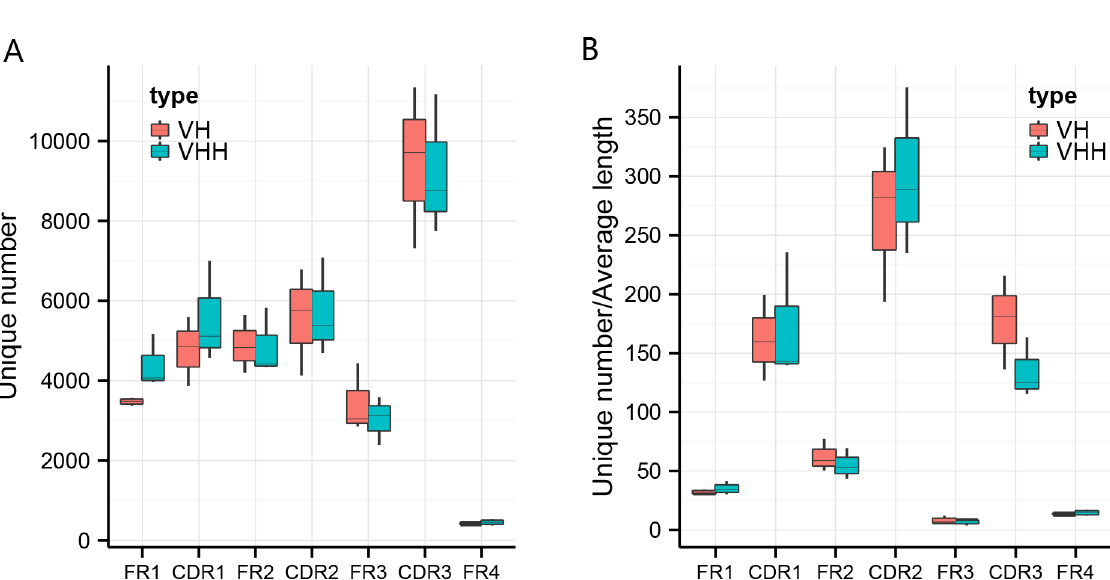
Fig 2. Box plots of the unique sequence numbers of each sub-region and diversity evaluation. Unique number represents the number of unique sequences within the reads. a The unique number of sub-regions including FR1, CDR1, FR2, CDR2, FR3, CDR3, and FR4 in three samples. b Diversity evaluation using the normalized unique number by length, which equals to unique number divided by average length of each sub-region. Box plot explanation: upper horizontal line of box, 75th percentile; lower horizontal line of box, 25th percentile; horizontal bar within box, the median of the three samples ’ data; upper end of the whisker, maximum of the three samples ’ data; lower end of the whisker, minimum of the three samples ’